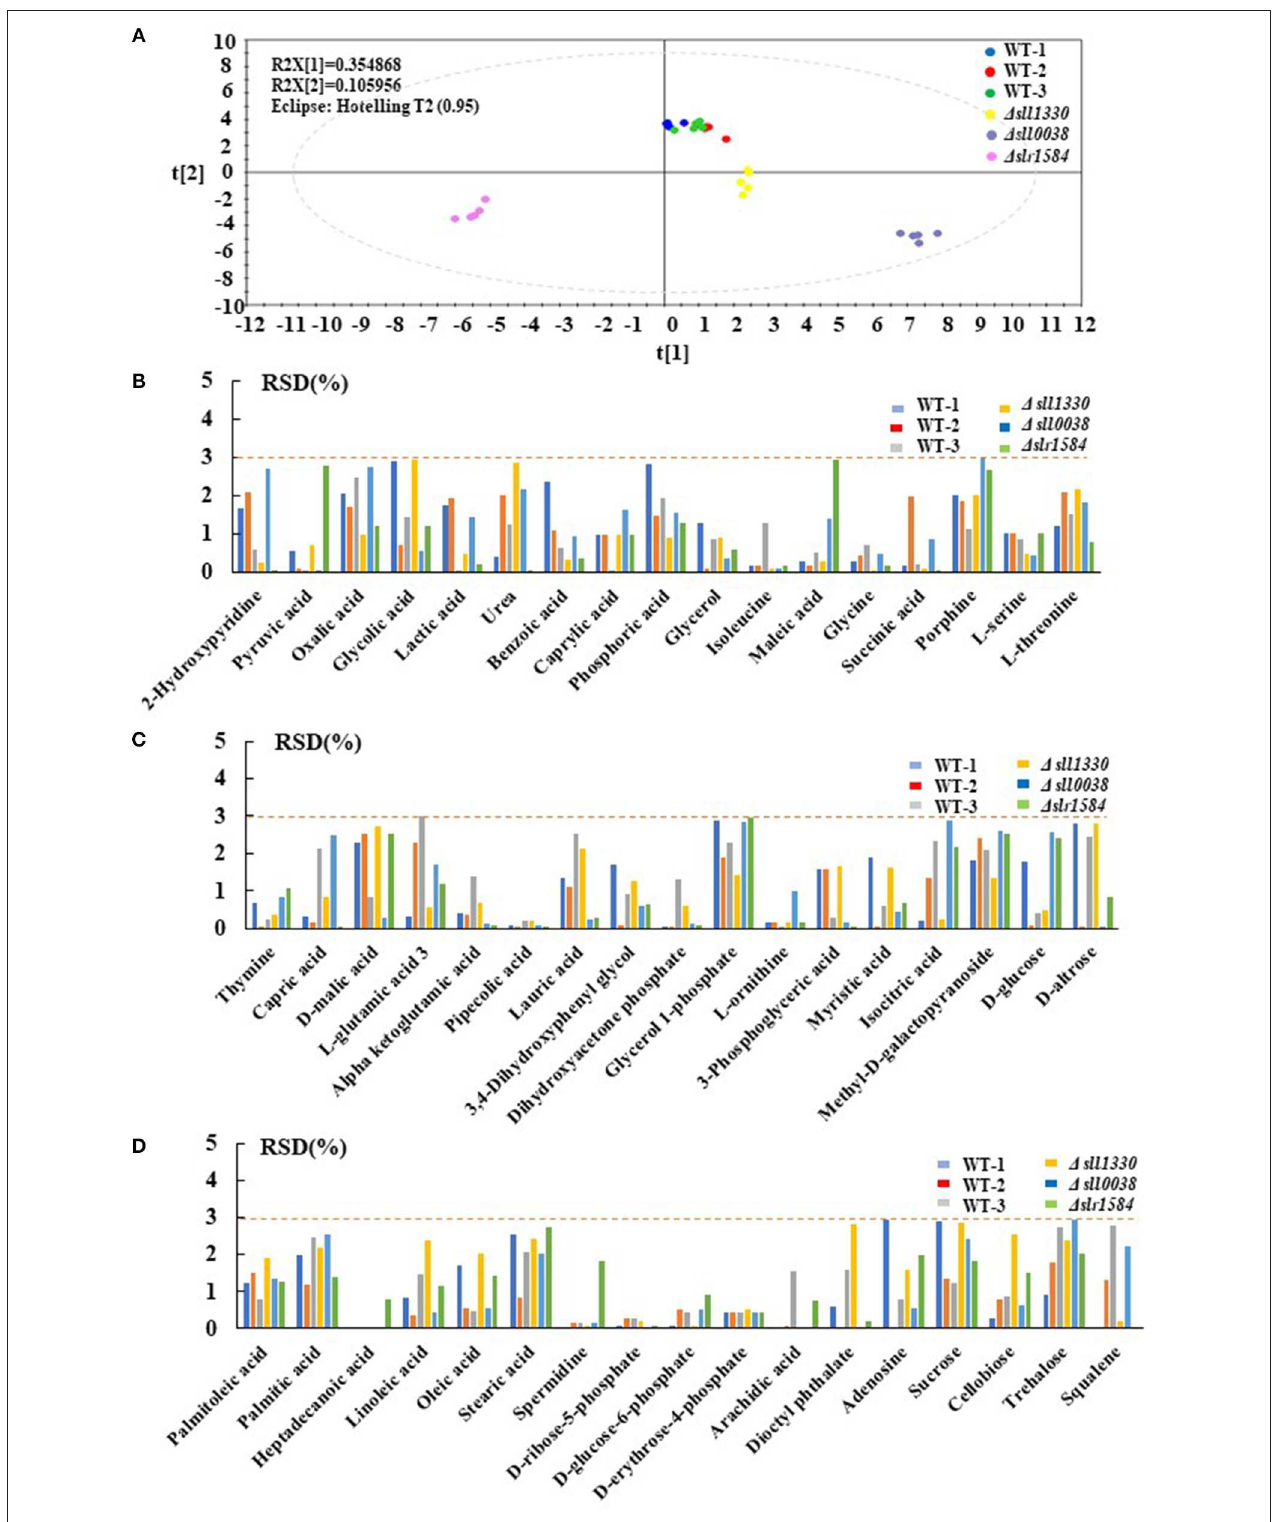
FIGURE 1 | Repeatability analysis three different batches of the wild type and 3 randomly selected mutants. (A) PCA plots of 3 different batches wild type and three randomly selected mutants; different colors represent different samples. (B–D) RSD analysis of different metabolites detected in the wild type and the mutants; different colors represent different